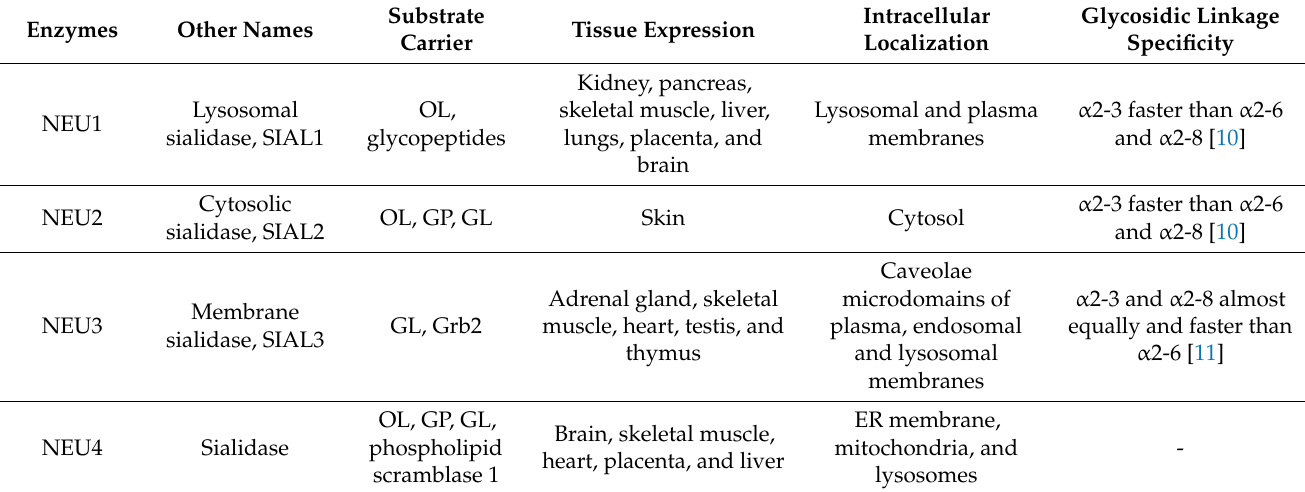
Table 2. Human Neuraminidases (NEUs). Information regarding alternative names, substrate carrier, intracellular localization, etc., corresponding to NEUs can be found in the table